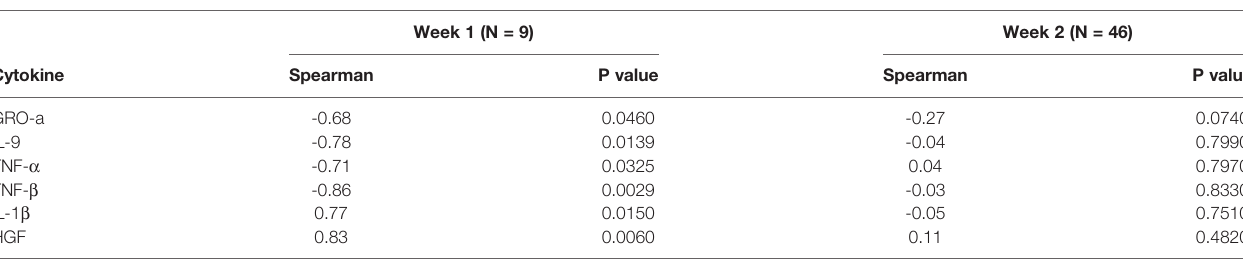
TABLE 2 | Cytokine which highly related with APACHE II score in COVID-19.